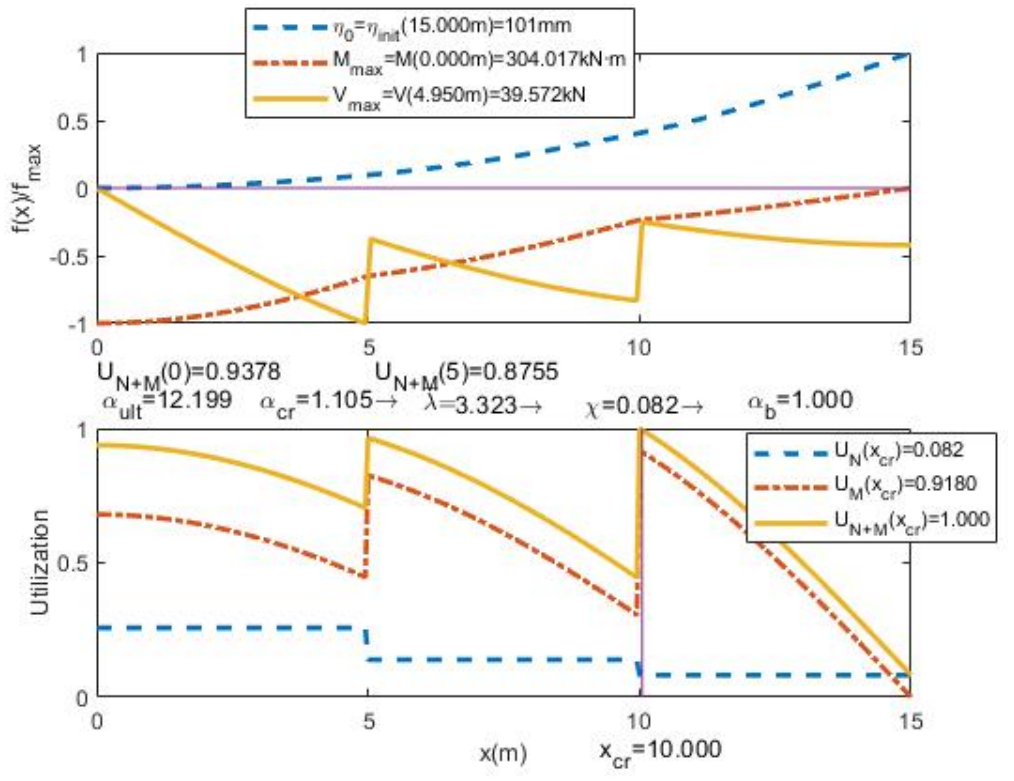
Figure 17. Example 5: UGLI imperfection η init , bending moment M , shear force V , and utilization factor U N + M = 1.0.